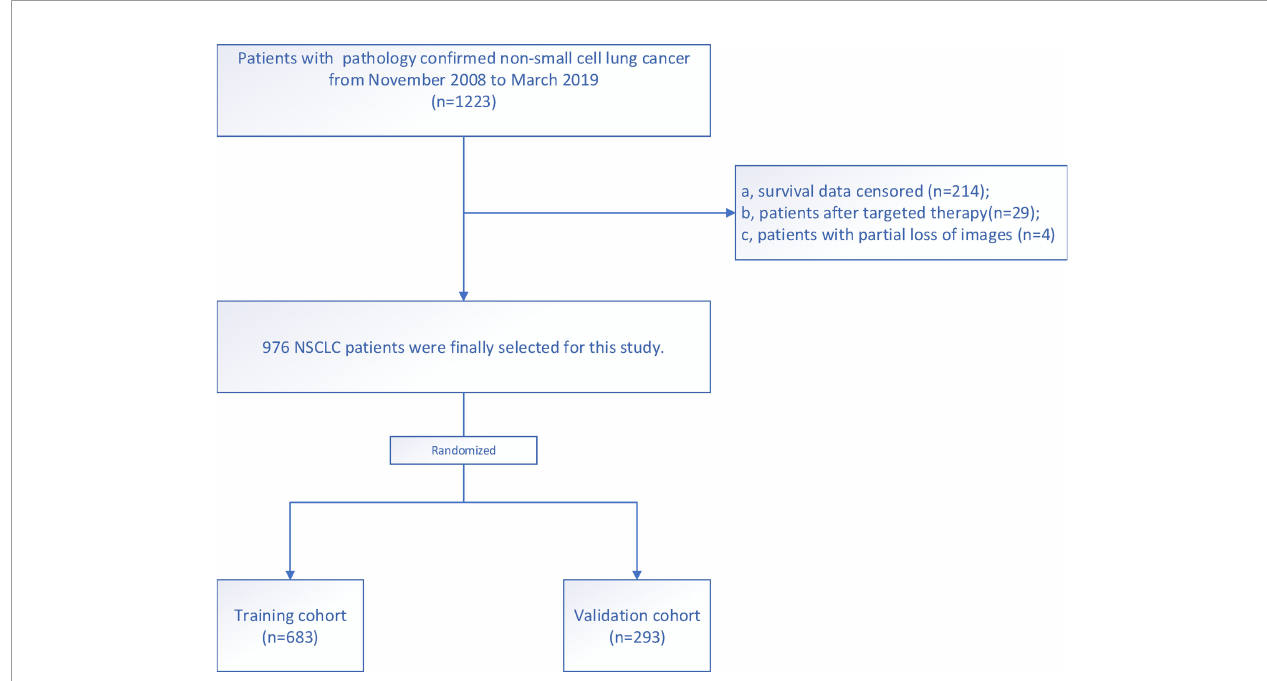
FIGURE 1 | Flow diagram of the enrollment of patients with non-small cell lung